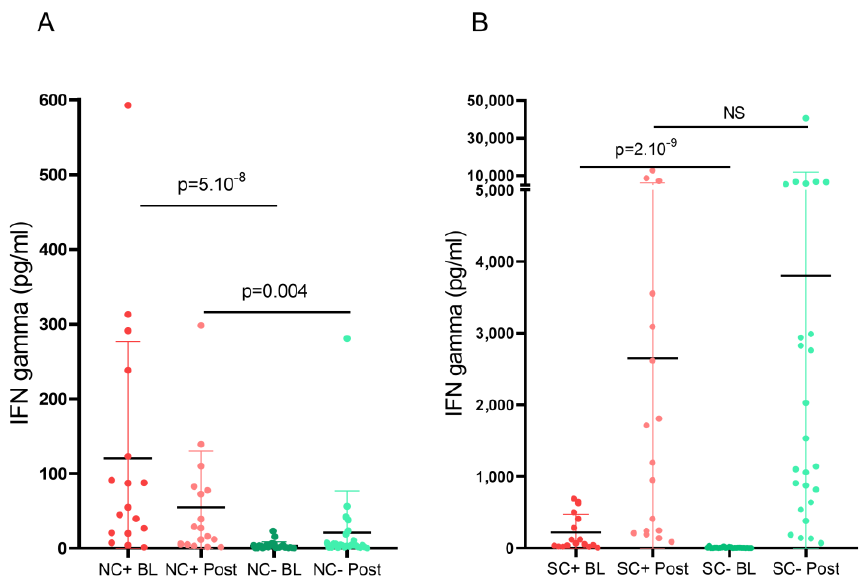
Figure 5. IFN- γ levels measured after in vitro stimulation of nucleocapsid ( A ) and spike peptides ( B ), in baseline and post-vaccination samples, in patients with or without prior COVID19. BL: baseline sample; C+: prior COVID-19; C − : without prior COVID-19; N: nucleocapsid; NS: non-significant; POST: post-vaccination sample; S: spike.